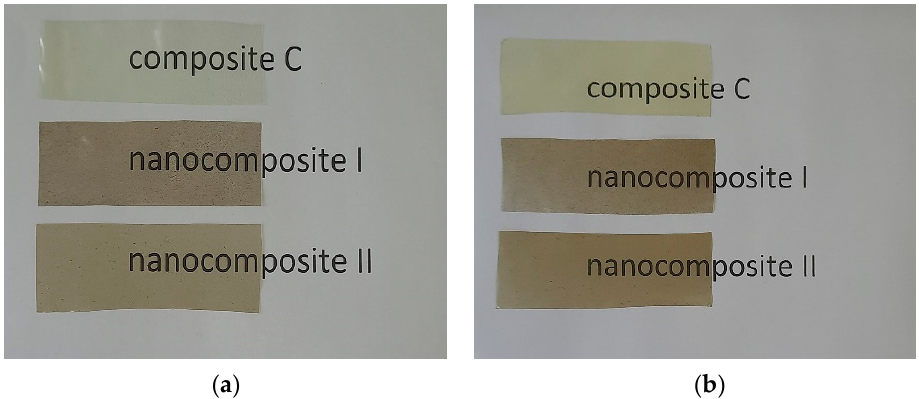
Figure 1. The obtained composites put on their printed names: ( a ) thin and ( b ) thick composites.